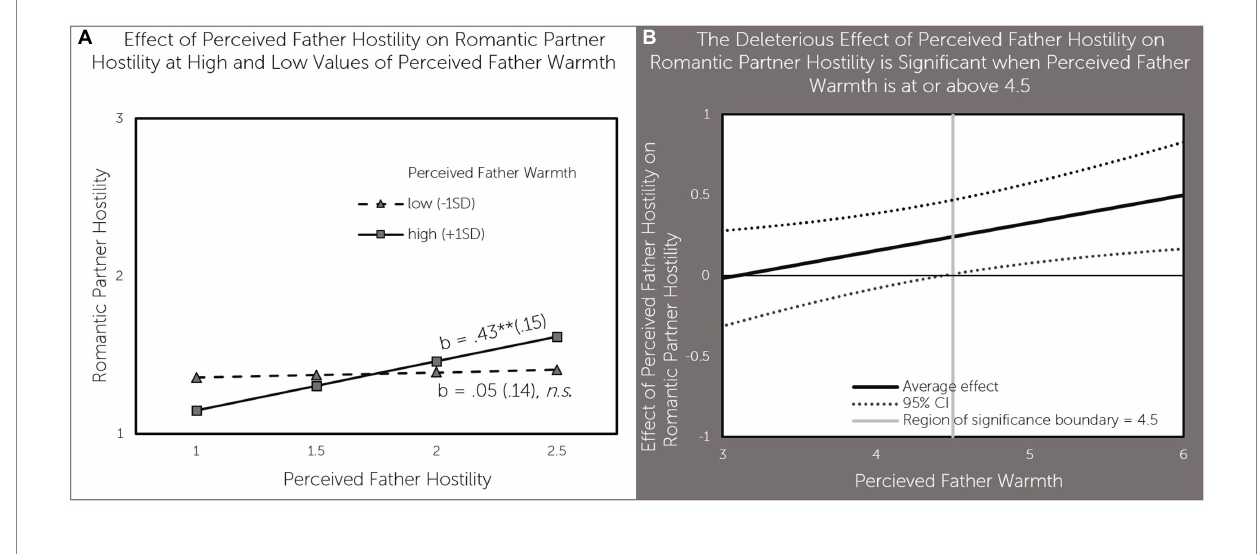
FIGURE 4 Perceived father warmth moderates the effect of perceived father hostility on daughter’s romantic partner hostility (A) effect of perceived father hostility on romantic partner hostility at high and low values of perceived father warmth; (B) The deleterious effect of perceived father hostility on romantic partner hostility is significant when perceived father warmth is at or above 4.5.